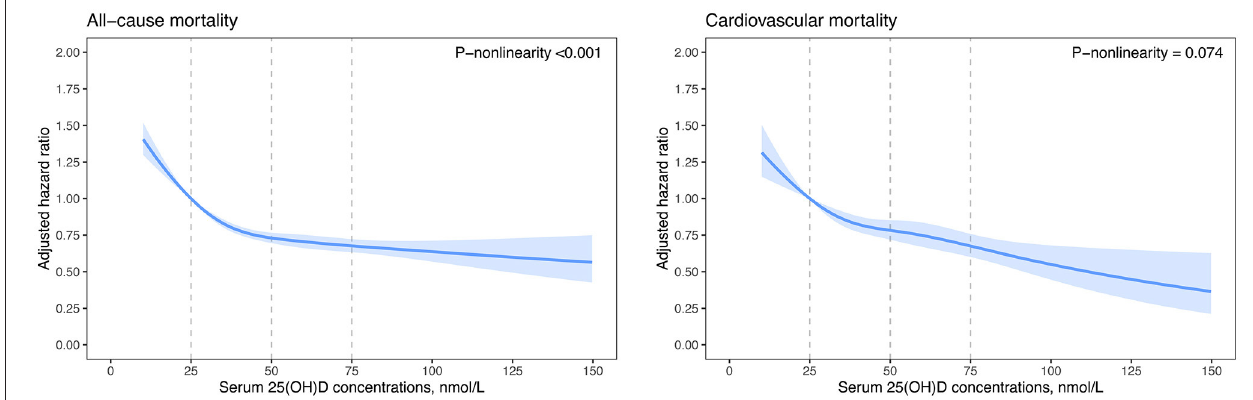
FIGURE 1 | Dose-response curves for serum 25(OH)D concentrations and all-cause and cardiovascular mortality. Hazard ratios (blue lines) and 95% confidence intervals (light blue shade) were adjusted for age (continuous), sex (male, female), and ethnicity (White, mixed, Asian, Black, Chinese, others, or unknown), education (college or university, vocational qualification, upper secondary, lower secondary, others, or unknown), Townsend deprivation index (in quintiles), household income ( < 18,000, 18,000–30,999, 31,000–51,999, 52,000–1,00,000, > 1,00,000 £, or unknown), smoking status (never smoker, former smoker, current smoker, or unknown), alcohol consumption (0, 0.1–4.9, 5.0–14.9, 15.0–19.9, 20.0–29.9, ≥ 30.0 g/day, or unknown), physical activity (inactive group, insufficient group, active group, or unknown), healthy diet score (in quintiles), and BMI ( < 18.5, 18.5–22.9, 23.0–24.9, 25.0–29.9, 30.0–34.9, or ≥ 35.0 kg/m 2 ), eGFRcr-cys ( < 30.0,